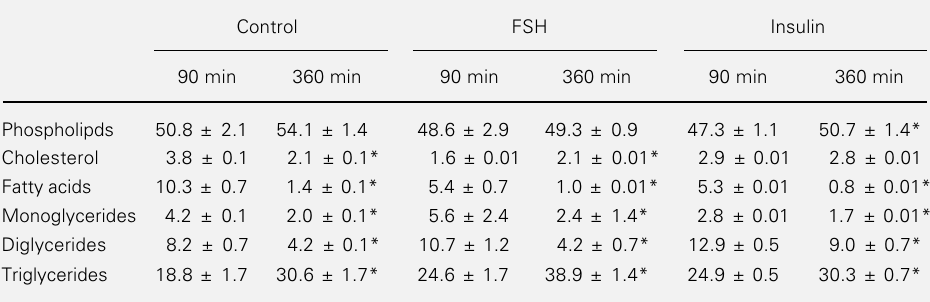
Table 3 - Effect of time of incubation with [1,2- 14 C]acetate (90 or 360 min) on Sertoli cells in culture pretreated with FSH or insulin for 16 h and on control cells. The results are reported as percent total incorporation of radioactivity into lipids in Sertoli cell cultures. Sertoli cells were pretreated for 16 h with FSH or insulin and incubated for 90 min with 1 (cid:181)Ci/ml and for 360 min with 0.5 (cid:181)Ci/ml [1,2- 14 C]acetate. The lipid extract was chromatographed and the radioactivity in lipid bands counted. Data are reported as the mean – SEM of 6 determinations. *P<0.05 compared to 90-min incubation time (Newman-Keuls